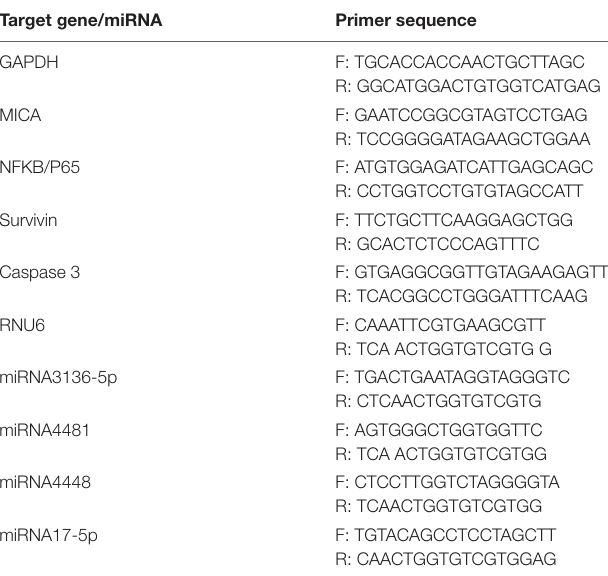
TaBle 1 | RT-qPCR primer sequences. Target